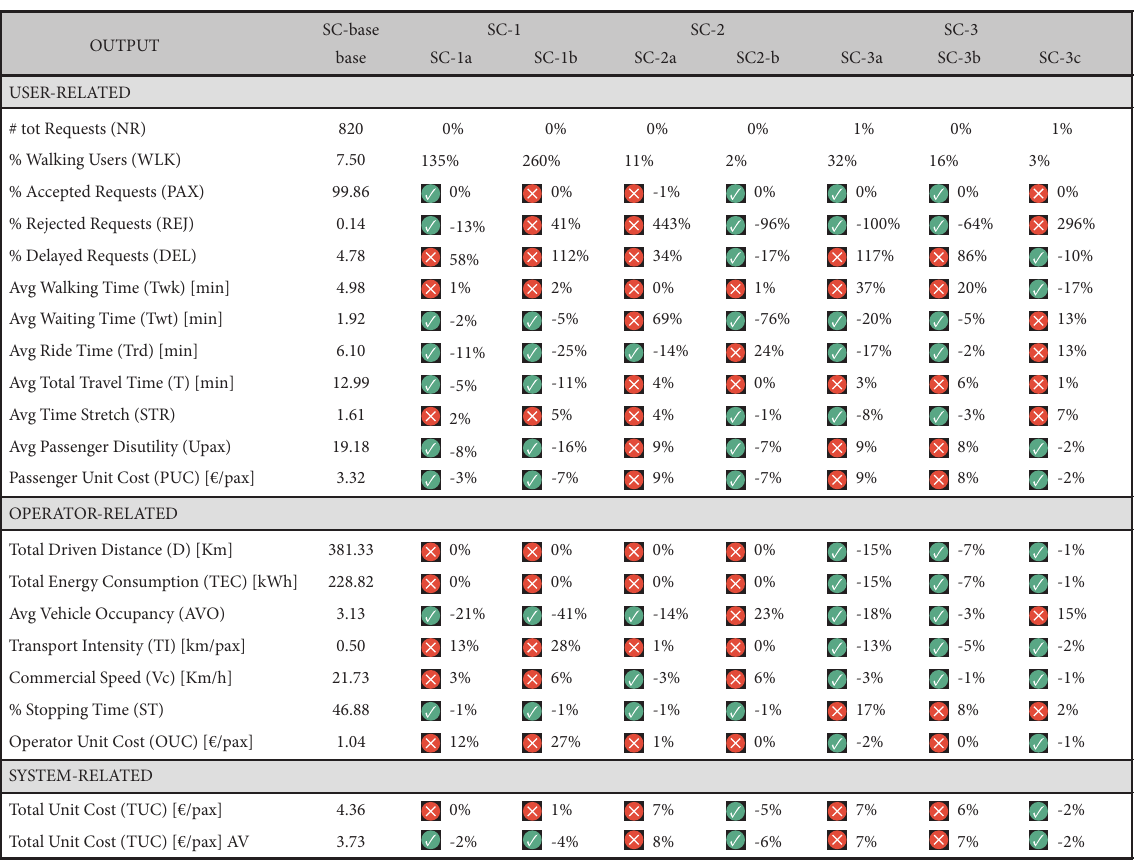
Figure 14: Summarizing table with FRF simulation outputs (for scenarios 1–3, percentage variations are reported with respect to